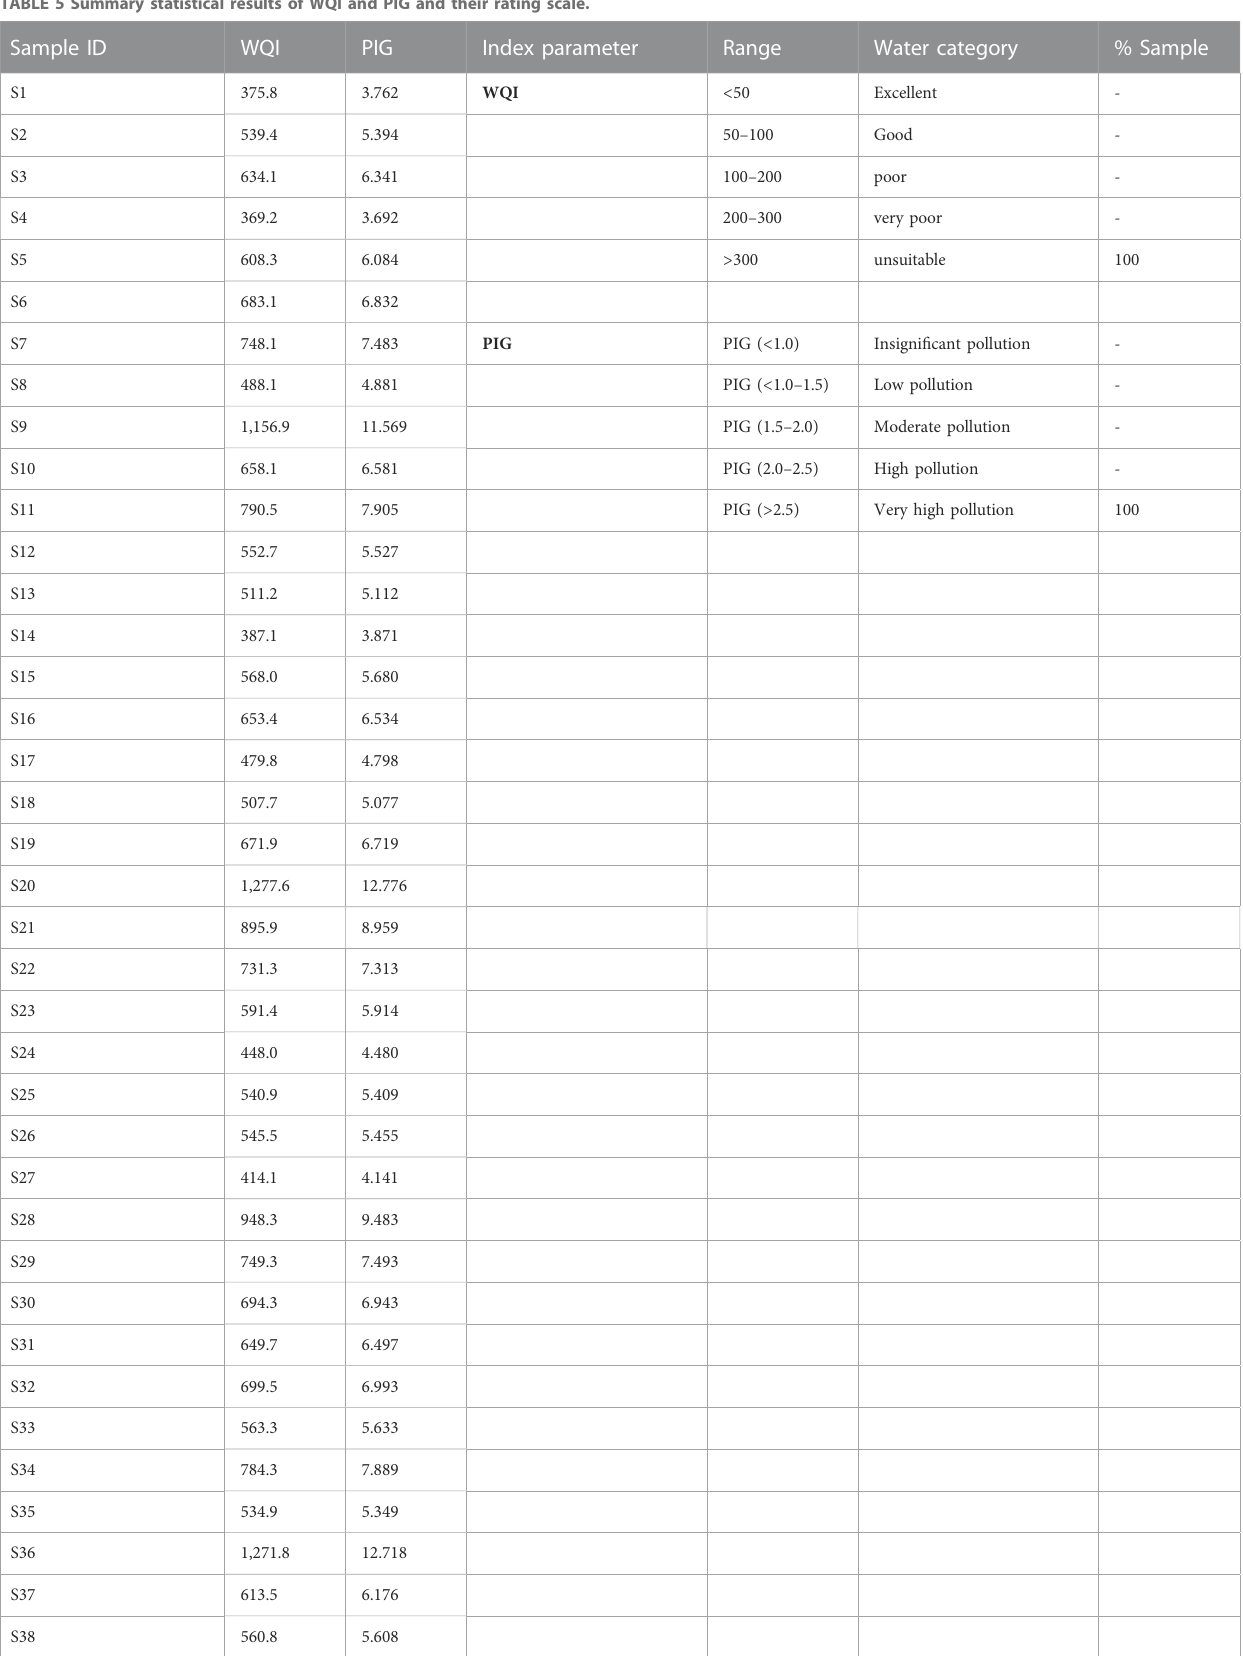
TABLE 5 Summary statistical results of WQI and PIG and their rating